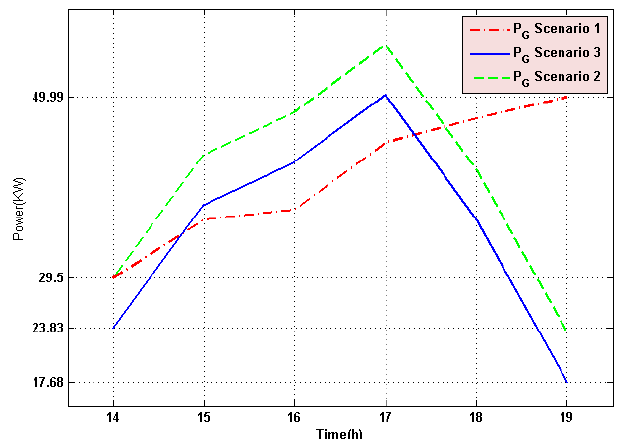
Figure 8. Variation of the demanded power from the grid in all analyzed scenarios.